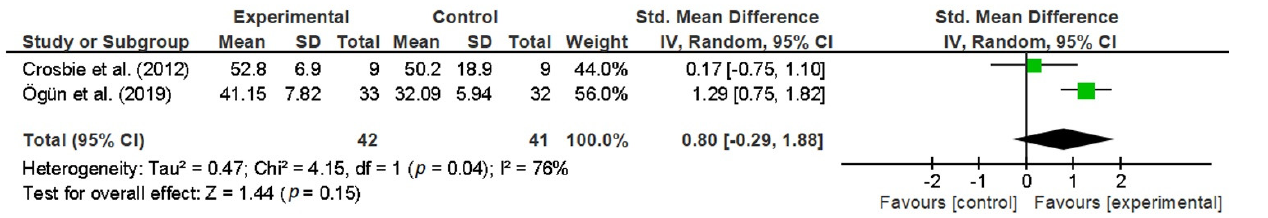
Figure 7. Pooled standardized mean differences and overall effect size (95% CI) on the ARAT immediately after the intervention.